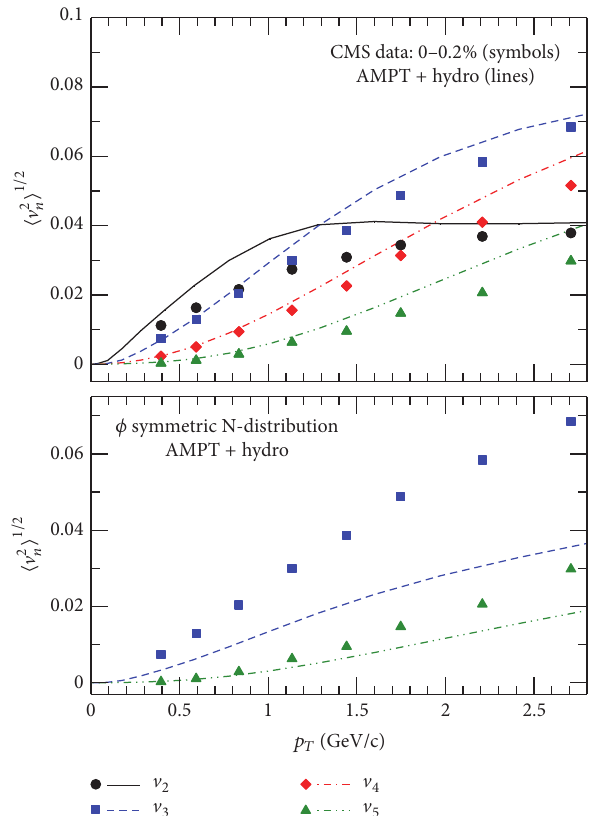
Figure 9: Comparison of a (2+1)D viscous hydrodynamics simula- tion with the initial condition from AMPT model to corresponding experimental data for root mean squared values of V 𝑛 for 𝑛 = 2–5; figure is from